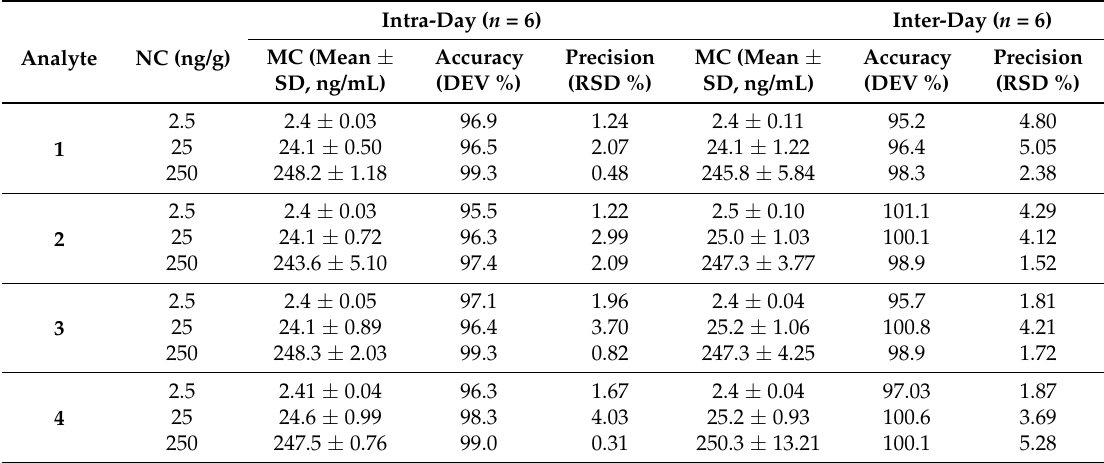
Table 2. Intra-day and inter-day accuracy and precision of this LC/MS/MS method.